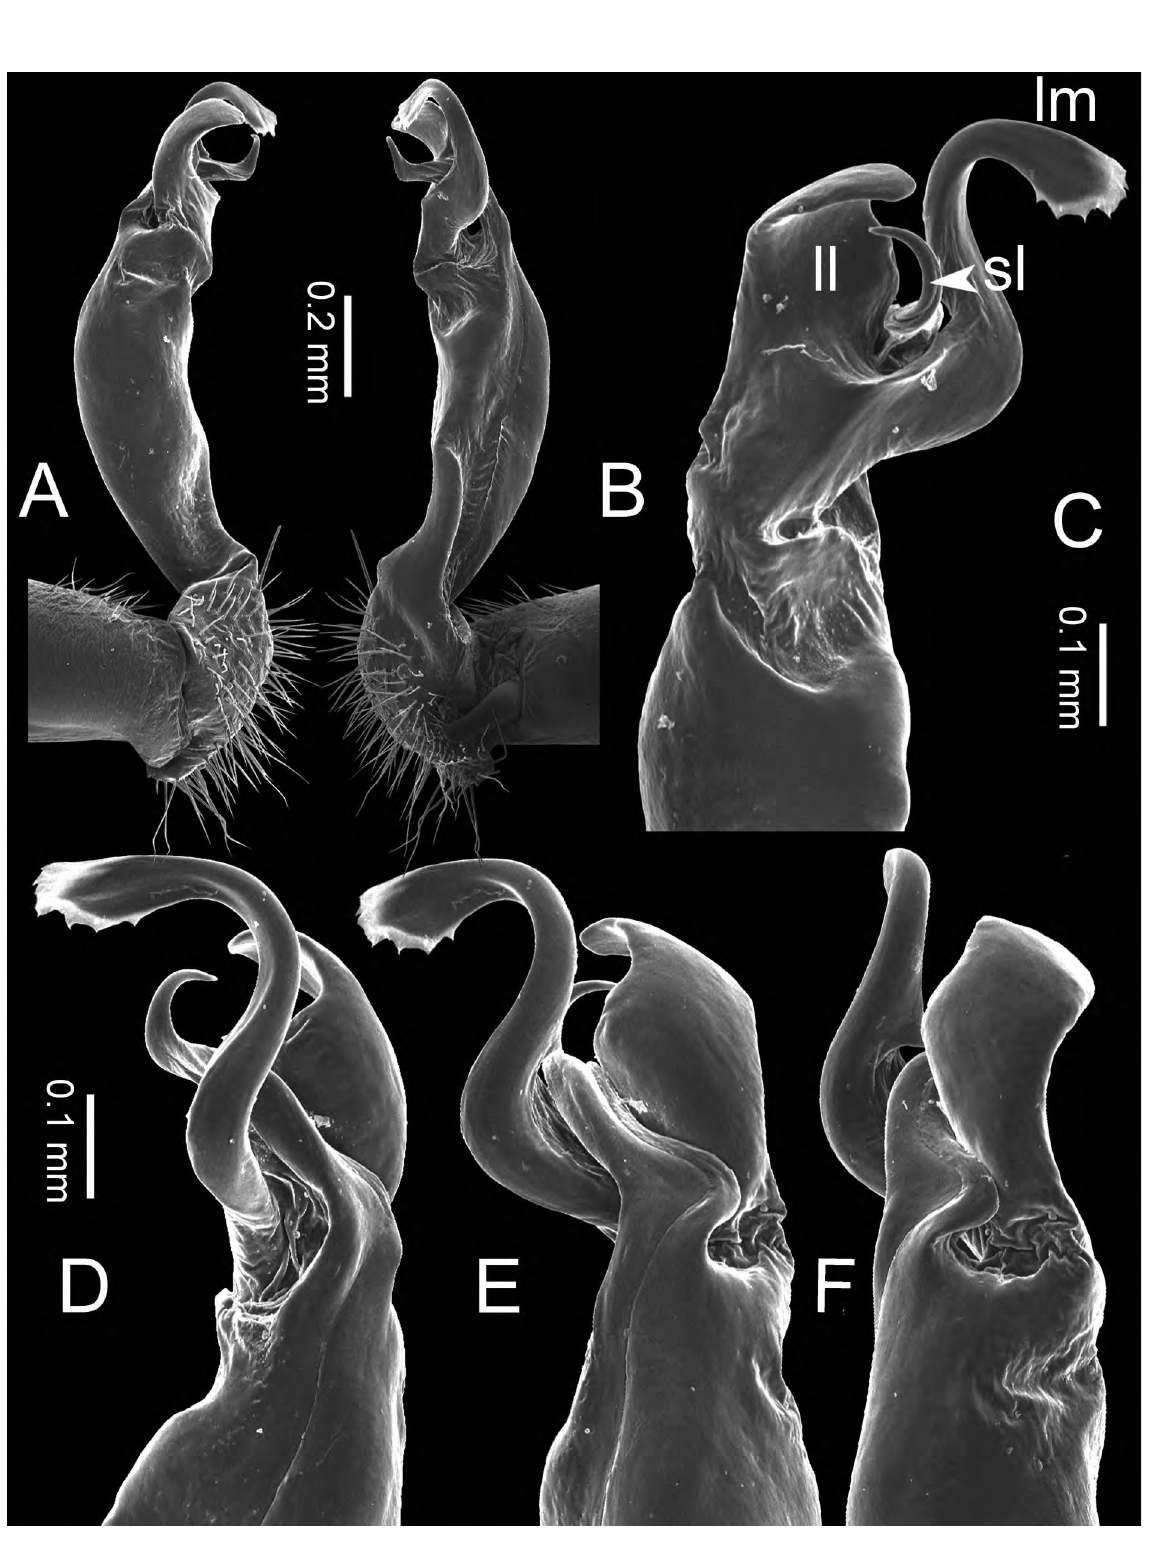
Fig. 21. Nagaxytes gracilis Srisonchai, Enghoff & Panha gen. et sp. nov., paratype (CUMZ-pxDGT00092), right gonopod. A . Lateral view. B . Mesal view. C . Ventral view. D , F . Subdorsal view. E . Dorsal